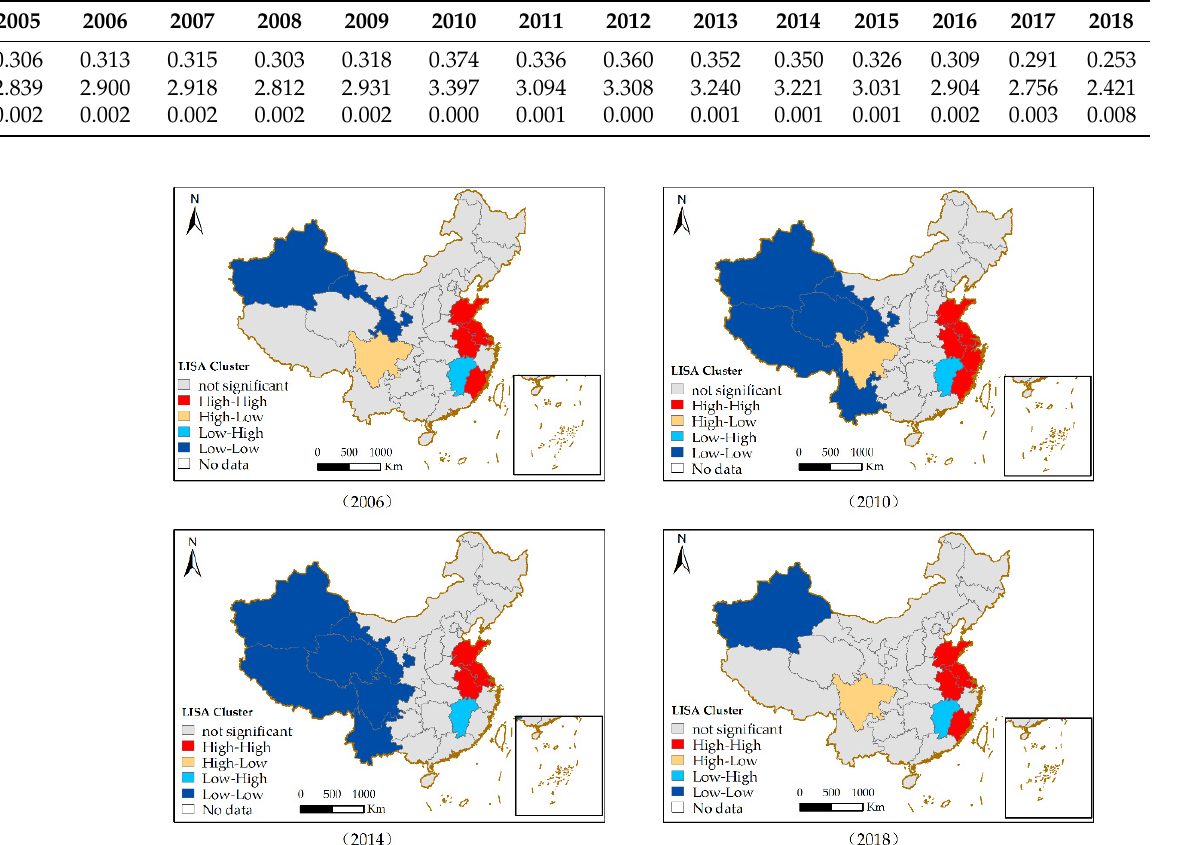
Table 3. Results of Lagrange multiplier (LM) test.